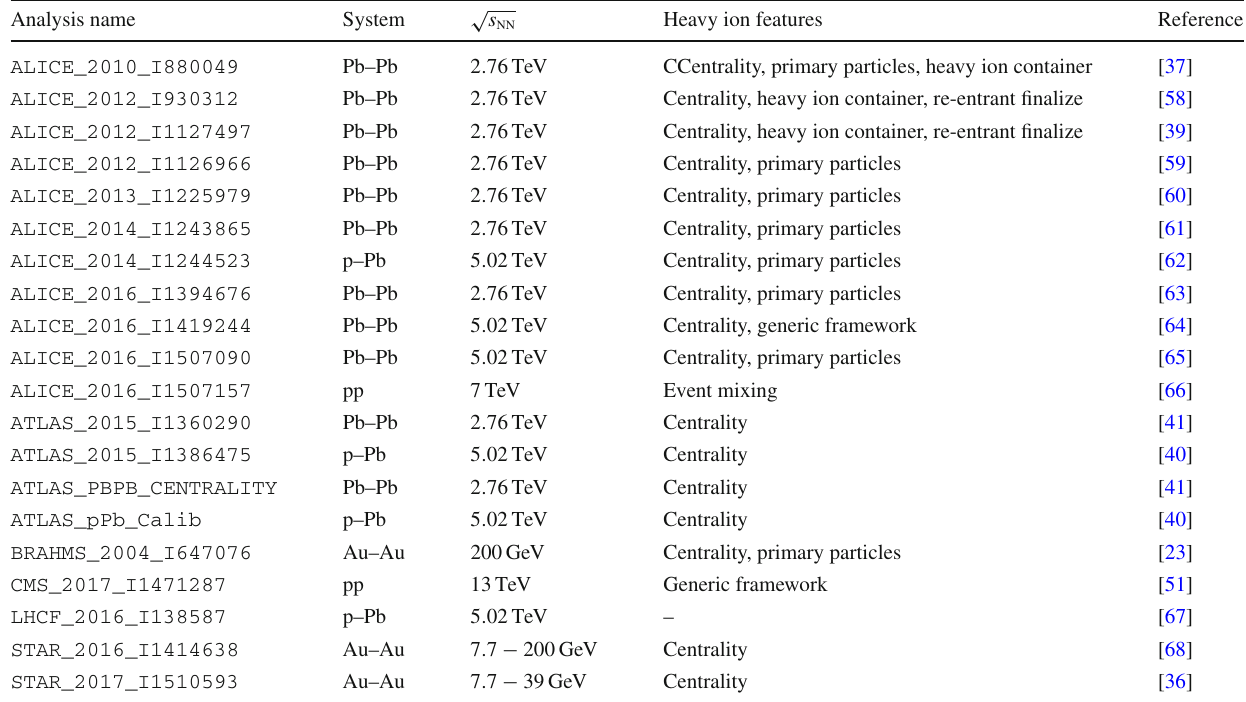
Table 1 All Rivet analyses implementing one or more heavy ion features, or heavy ion beams. An up-to-date list can be found at https://rivet.